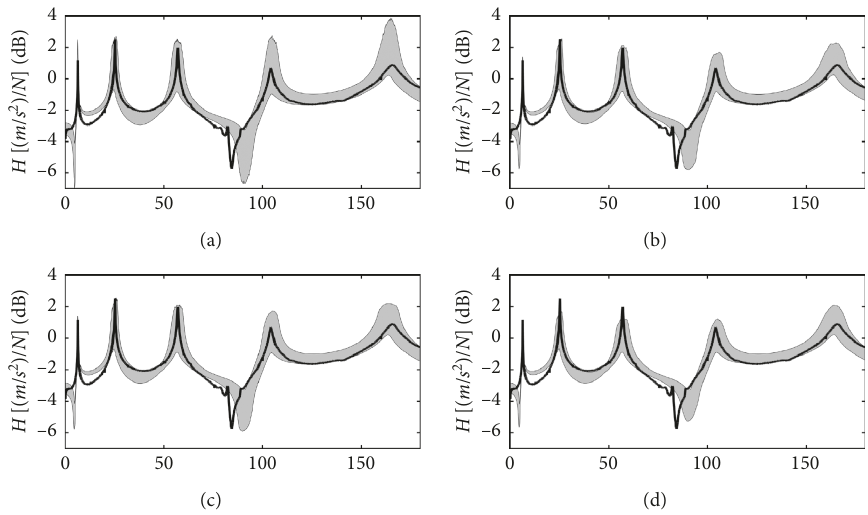
Figure 11: FRFs for scenario A1 and prior covariance matrix with λ credibility interval provided by model predictions. (a) Freq. (Hz) DH1. (b) Freq. (Hz) DH2. (c) Freq. (Hz) DH3. (d) Freq. (Hz) DH4.